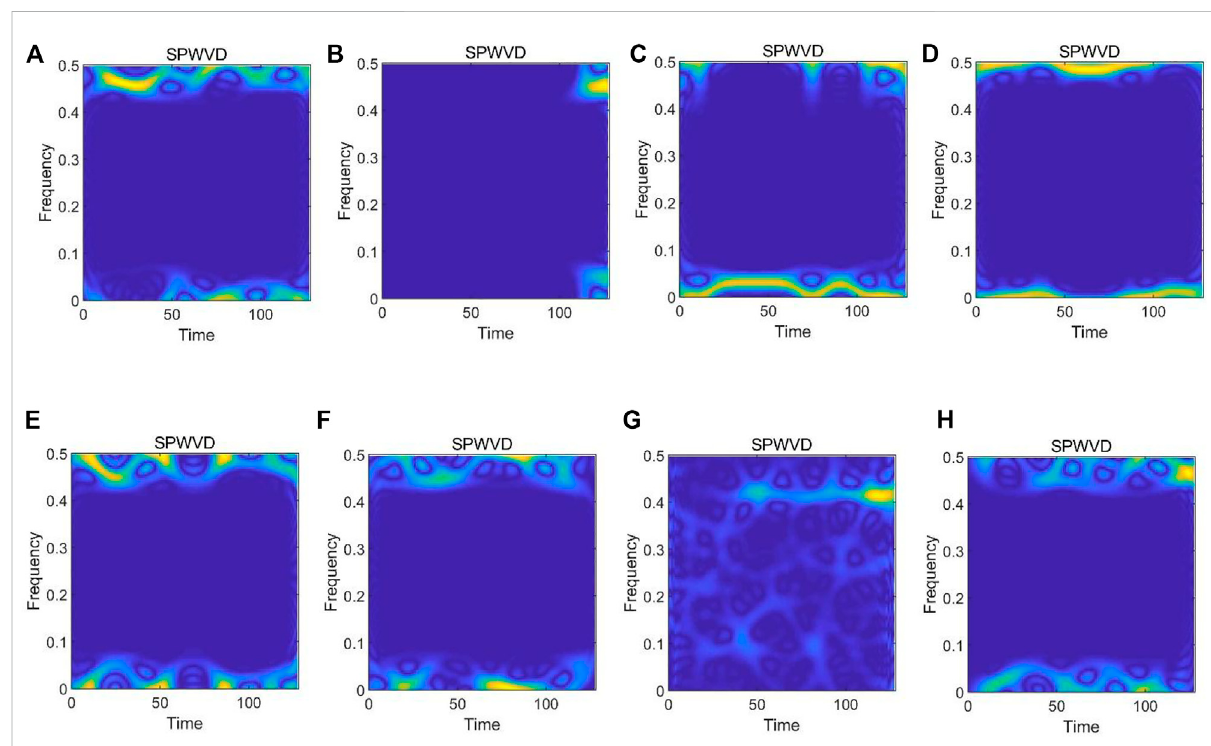
FIGURE 3 Smoothed pseudo Wigner – Ville distribution of modulated signals at SNR = 18 dB in RadioML 2016.10A dataset. (A) 8PSK, (B) BPSK, (C) CPFSK, (D) GFSK, (E) PAM4, (F) QAM16, (G) QAM64, (H)